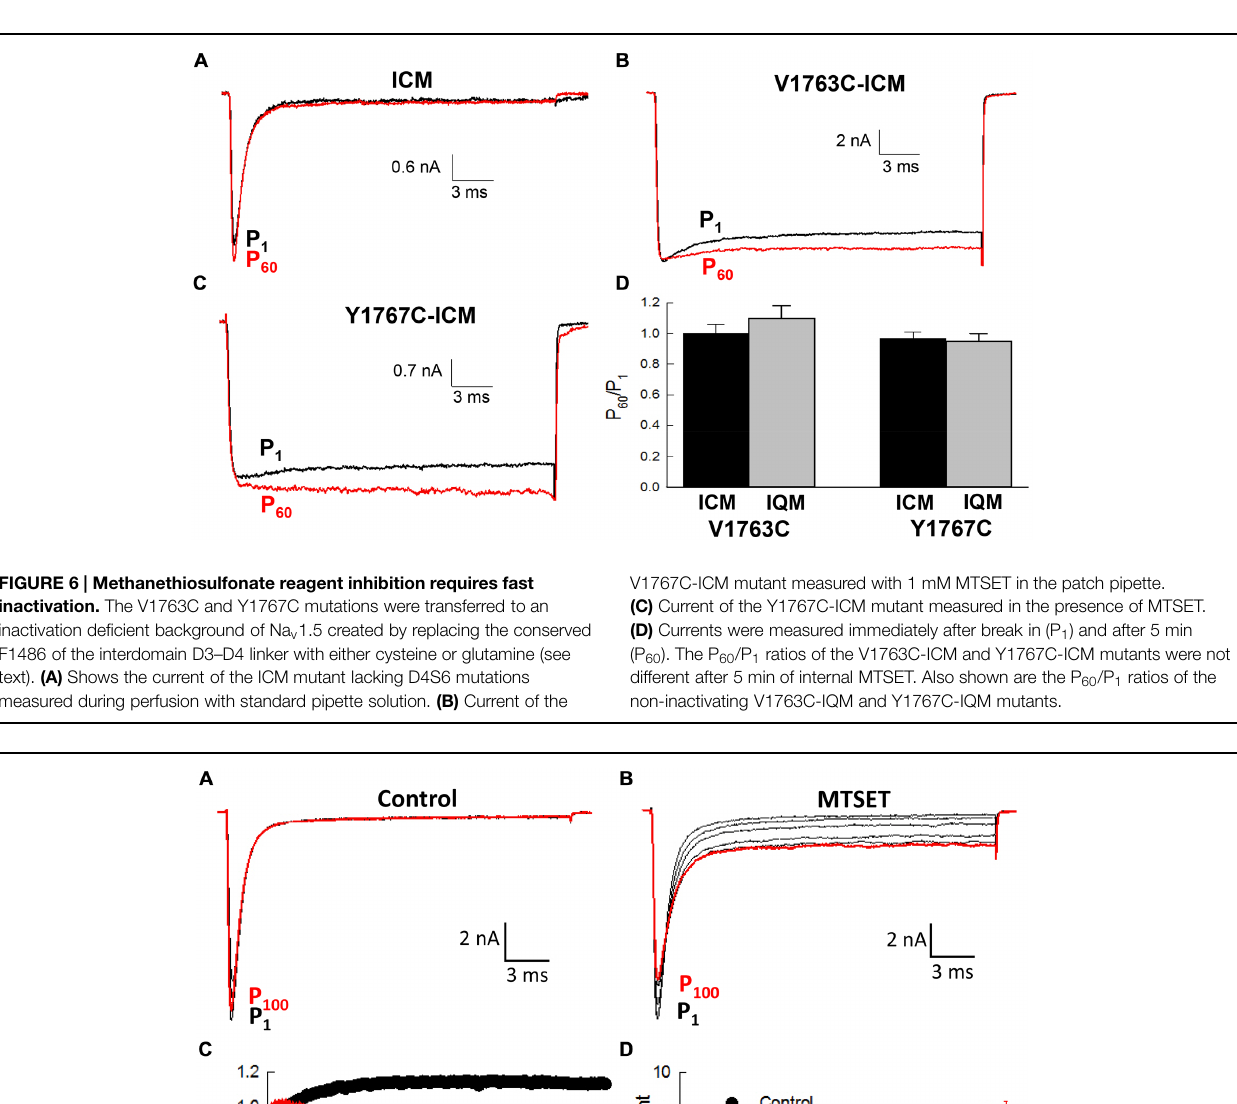
FIGURE 7 | Internal MTSET induces a persistent current in the I1770C mutant. (A) The currents of the I1770C mutant measured in reagent-free pipette solution. Currents are shown immediately after break-in (P 1 ) and after 0.5, 1, 3, 5, and 8 min (P 100 ).